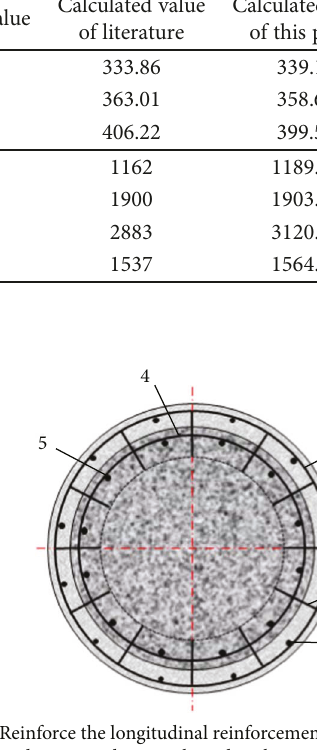
Table 1: The calculation value of the formula is compared with that of the literature test. Data sources